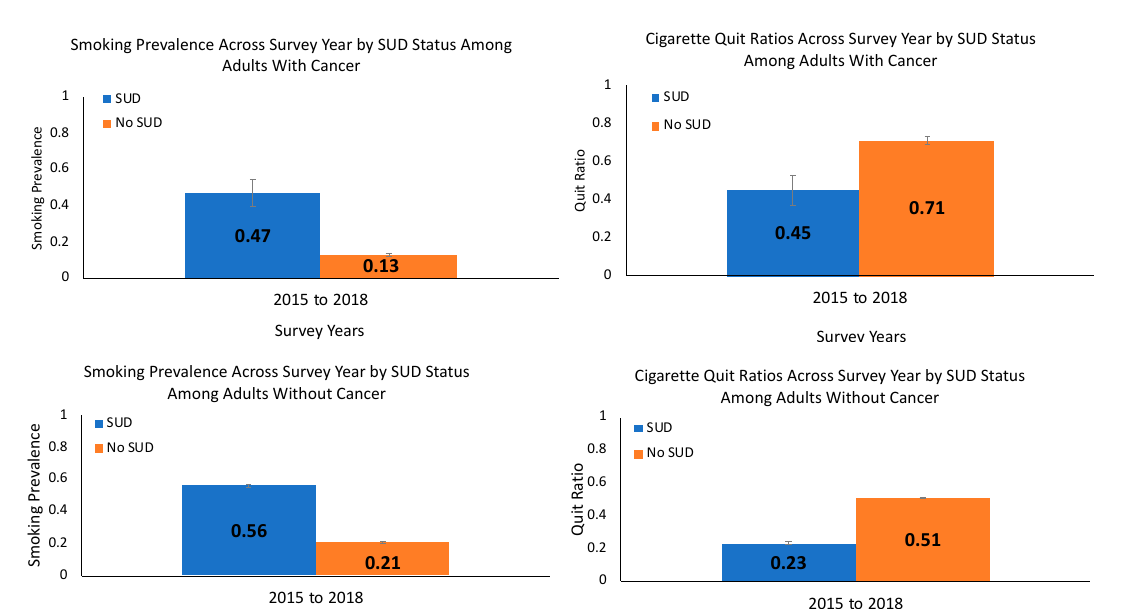
Figure 1. Current smoking prevalence and quit ratios (weighted %, standard error of the mean) among adults with a past-year cancer (upper panels) and without a past-year cancer (lower panels) by substance use disorder (SUD) status in 2015–2018. Notes: Data are from the 2015–2018 National Surveys on Drug Use and Health. The SUDs × cancer diagnosis status interaction was not significant for smoking prevalence (adjusted odds ratio (AOR) = 1.2; 95% confidence interval (CI): 0.7, 2.1; p = 0.56) or quit ratios (AOR = 1.0; 95% CI: 0.5, 2.0; p = 0.91) in logistic regression analyses that adjusted for age, gender, race/ethnicity, and annual income.